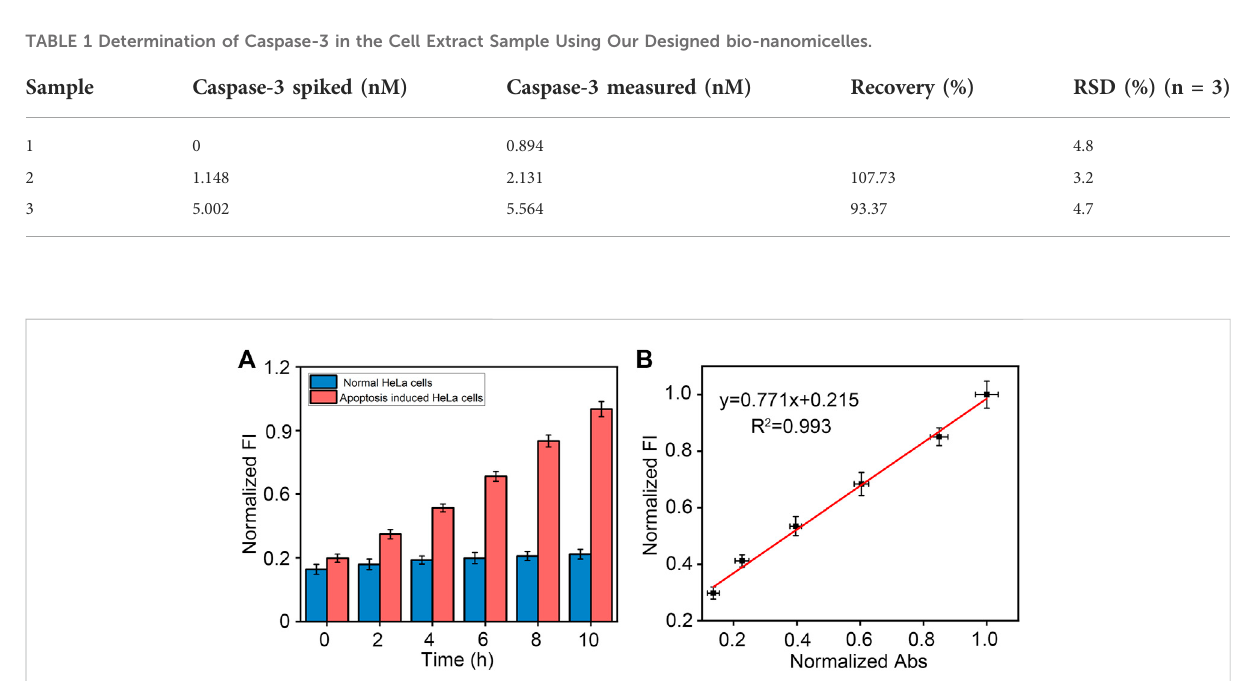
FIGURE 4 (A) Detection of caspase-3 in HeLa cell lysates with or without apoptosis-inducing over time using our designed method. Excitation and emission wavelength of FAM is 492 and 522 nm. (B) Comparison of commercially available caspase-3 assay kits with our designed